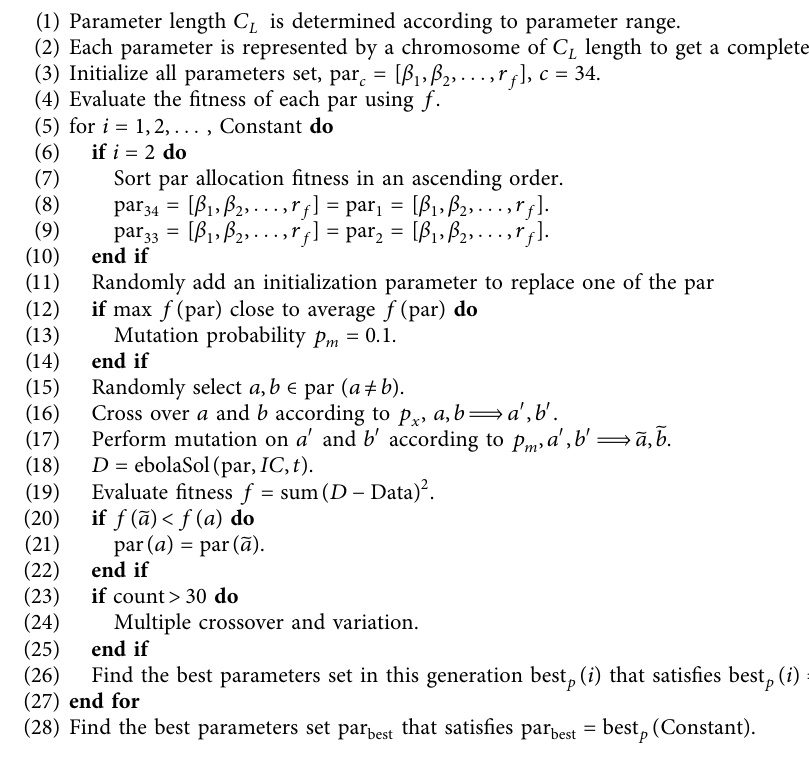
A LGORITHM 1: Parameter estimation of GA.